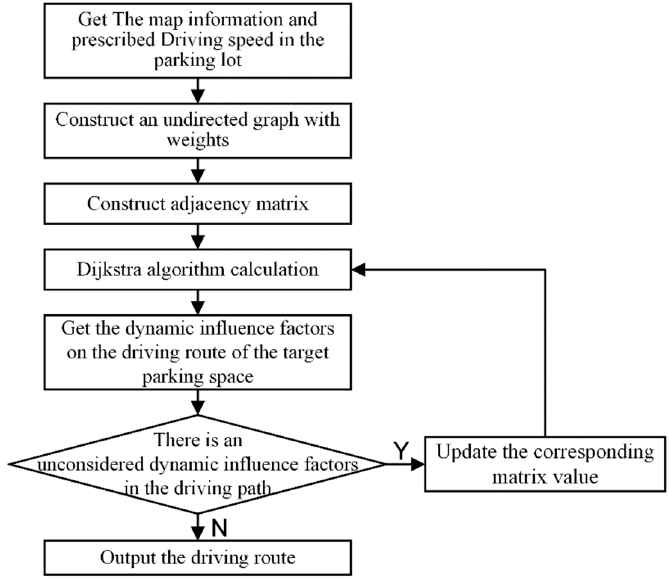
Figure 3. Route planning process.